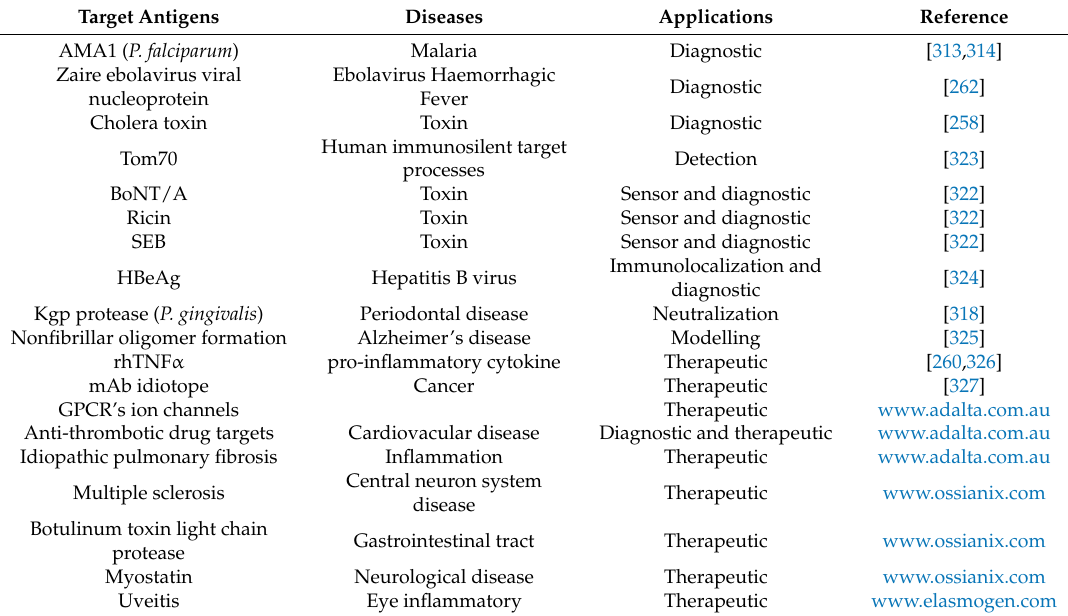
Table 3. The applications of shark V NAR against specified antigens from various